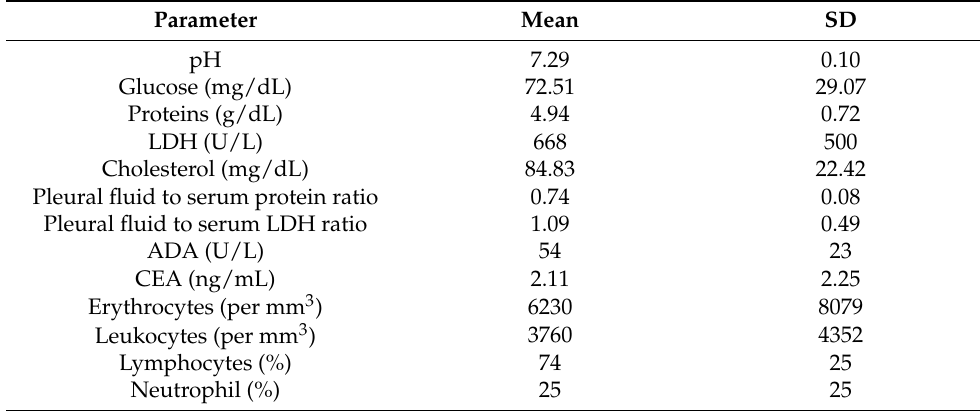
Table 2. Biochemical characteristics of pleural fluid in patients with tuberculous pleural effusion. Parameter